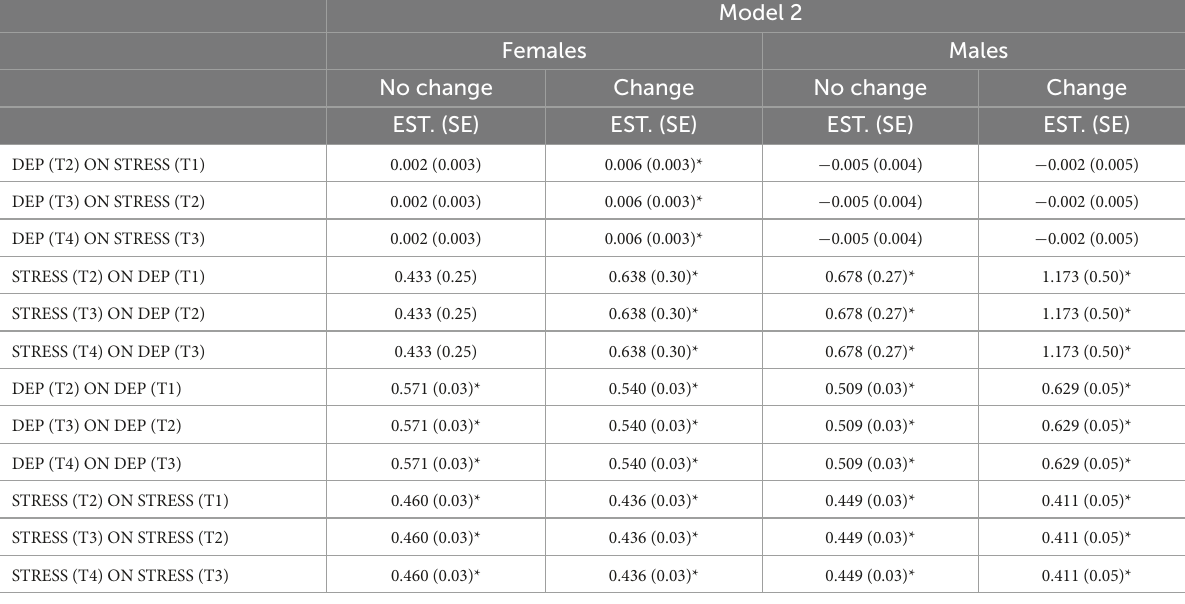
TABLE 4 Unstandardized estimates and standard errors for the ARCL Model 2 (grouping by sexual identity change status and sex assigned at